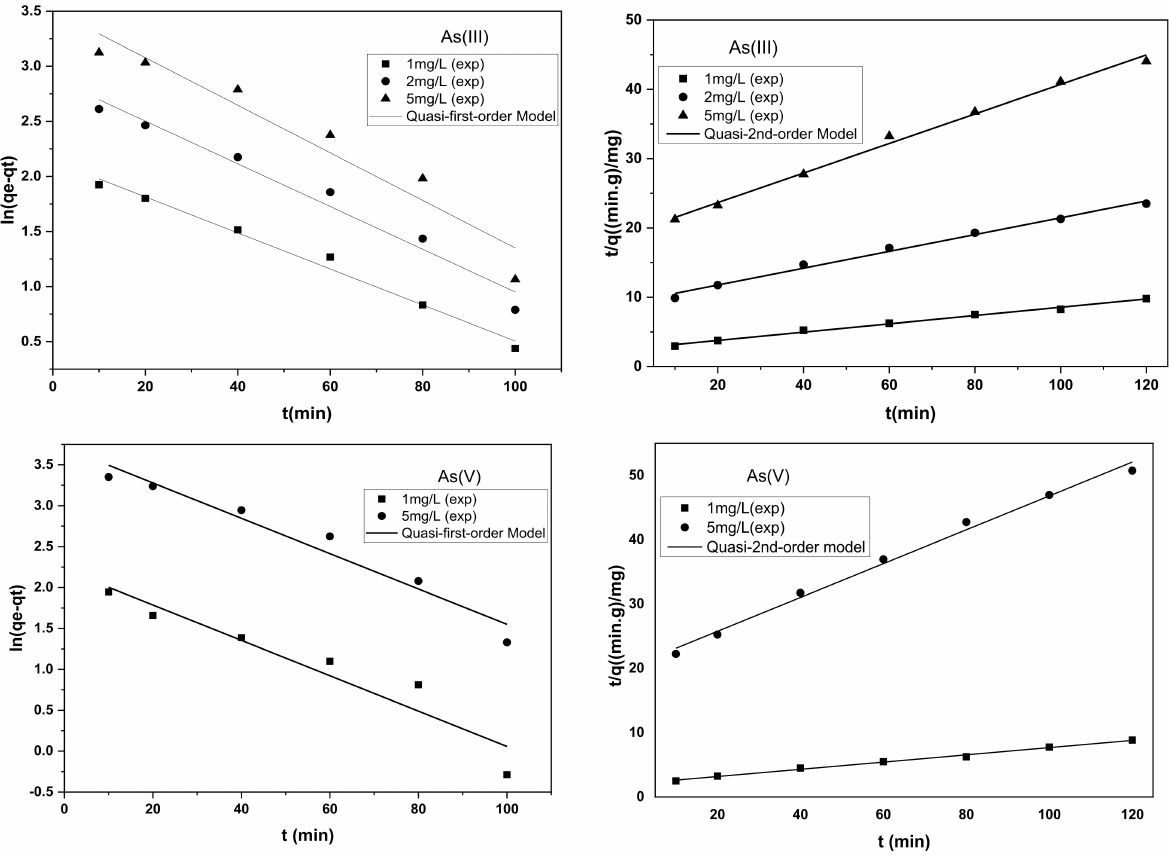
Figure 12. Quasi-first-order kinetics and quasi-second-order adsorption kinetic curves of As(III) and As(V). Table 9. Quasi-first-order and quasi-second-order adsorption kinetic fitting data for As(III) and As(V). Initial Concentration Metal